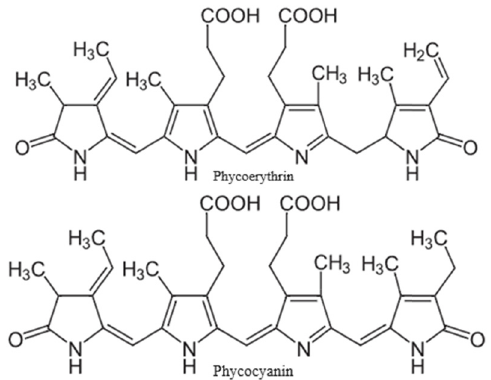
Figure 3: Chemical structure of phycoerythrin